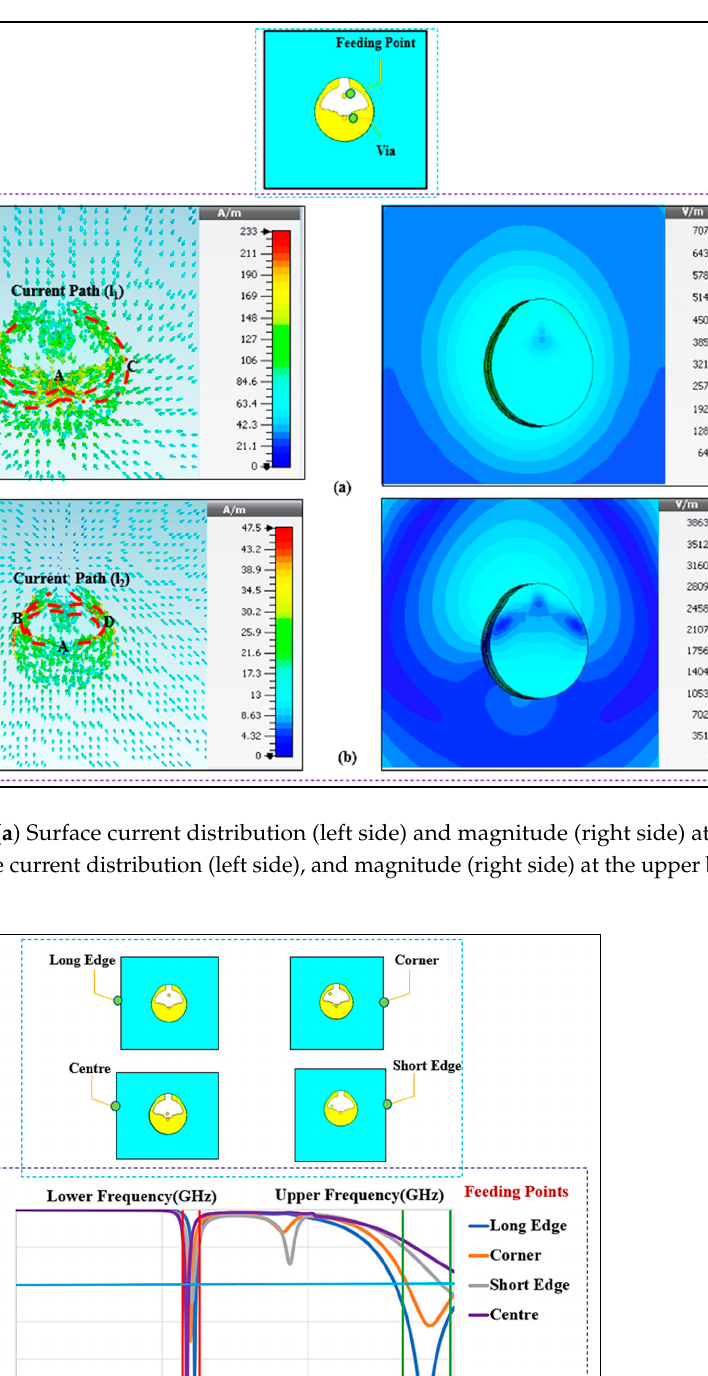
Figure 9. Radiation patterns of BSA on 3-layer phantom models at lower (left) and upper (right) bands in various scenarios (Solid black line, H plane; red line, E plane, at a gap of 5 mm).